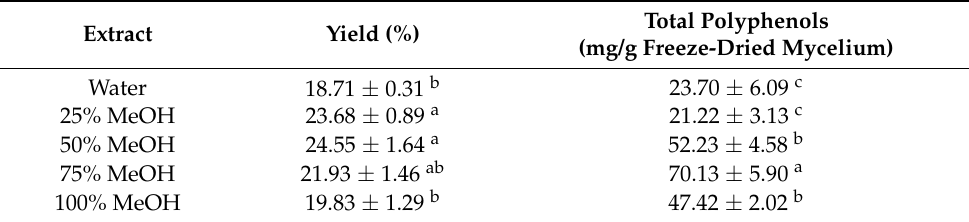
Table 1. The yield and total polyphenol content of Phellinus linteus mycelium freeze-dried powder from different extraction methods. Total Polyphenols Extract Yield (%) (mg/g Freeze-Dried Mycelium) Water 18.71 ± 0.31 b 23.70 ± 6.09 c 25% MeOH 23.68 ± 0.89 a 21.22 ± 3.13 c 50% MeOH 24.55 ± 1.64 a 52.23 ± 4.58 b 75% MeOH 21.93 ± 1.46 ab 70.13 ± 5.90 a 100% MeOH 19.83 ± 1.29 b 47.42 ± 2.02